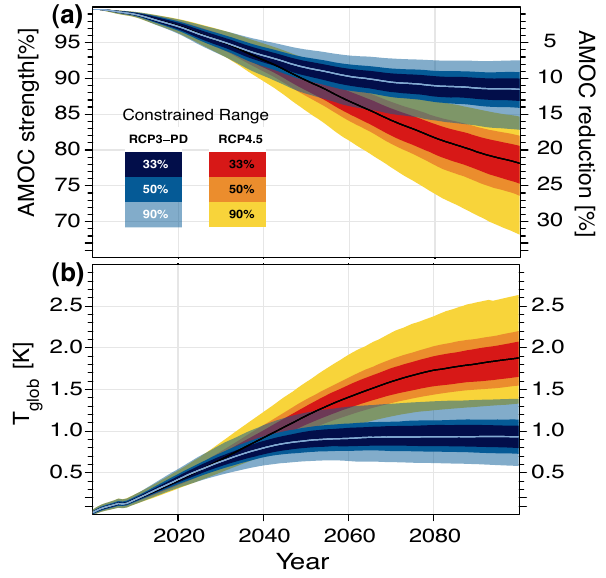
Fig. 3. Comparison of the calibrated model outcome (thick line) with the AOGCM reference data for the 1% CO 2 increase scenario from Gregory et al. (2005) (thin line). Our emulation outcome re- Fig. 4. Probabilistic future projections for the RCP3-PD and Fig. 4. Probabilistic future projections for the RCP3-PD and produces the weakening trend of all five AOGCMs. RCP4.5 scenario relative to the year 2000: (a) AMOC based on the equally weighted five model ensemble (individual model pro- RCP4.5 scenario relative to the year 2000: (a) AMOC based on jections are shown in Fig. S1 of the Supplement). (b) Correspond- the equally weighted five model ensemble (individual model pro- ing global mean temperature obtained from the MAGICC6 model jections are shown in Fig. S1 of the Supplement) (b) Correspond- emulating IPCC AR-4 models. ing global mean temperature obtained from the MAGICC6 model emulating IPCC AR-4 models. compared to the uncertainty of the individual model pa- rameters. Our results are in very good agreement with a historical constrained Bayesian model study by Urban and Keller (2010), where a weakening of 17 % is projected for a 21st century warming of 1.5 K.